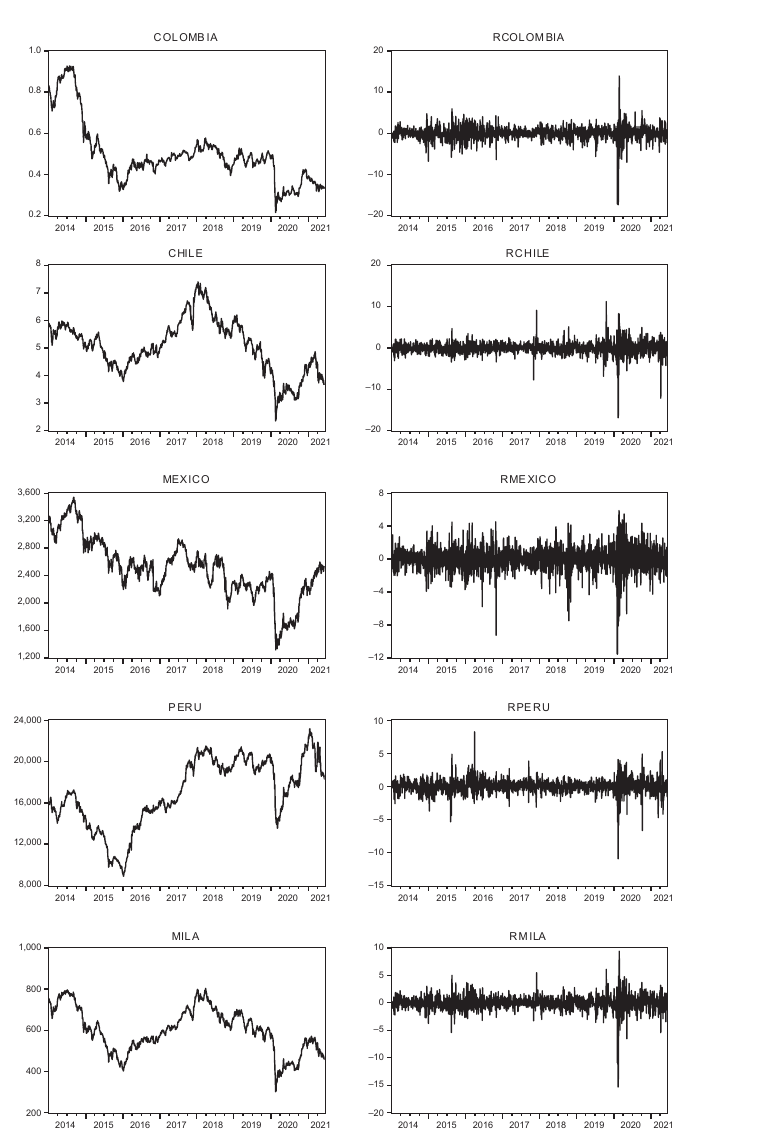
Figure 1. Daily prices and logarithmic stock index returns for Latin American emerging